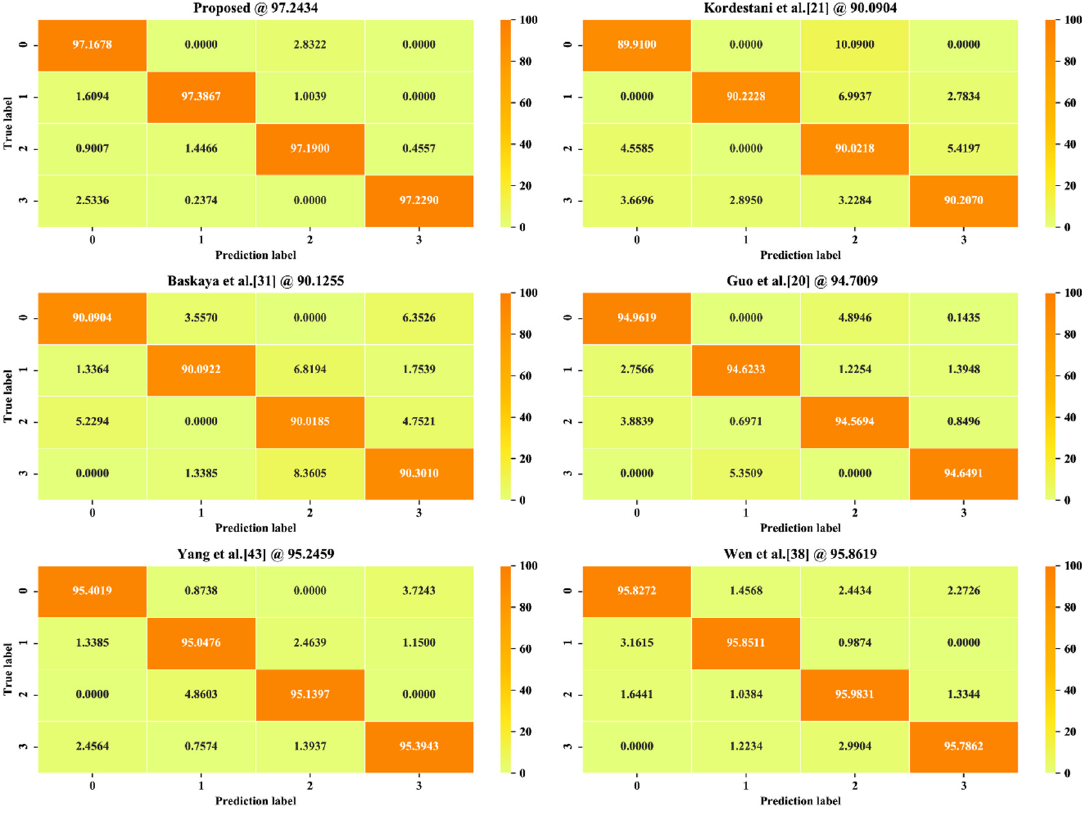
Figure 16. Confusion matrix comparison (in percent).